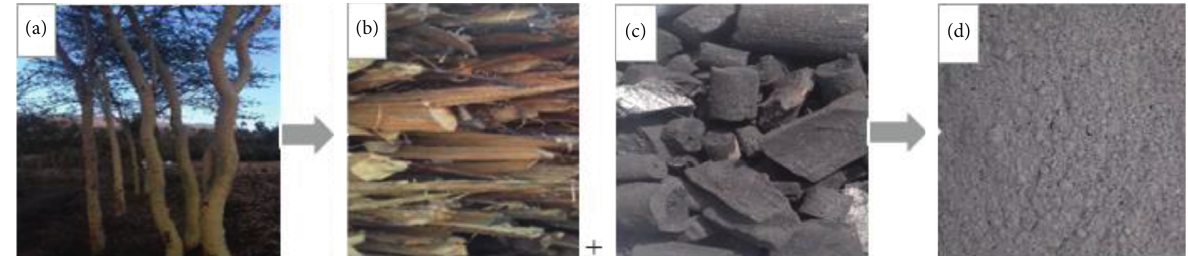
Figure 1: (a) Girar ( acacia bussei ) tree, (b) stem, (c) charcoal used for fuel source, and (d) disposed waste ash.